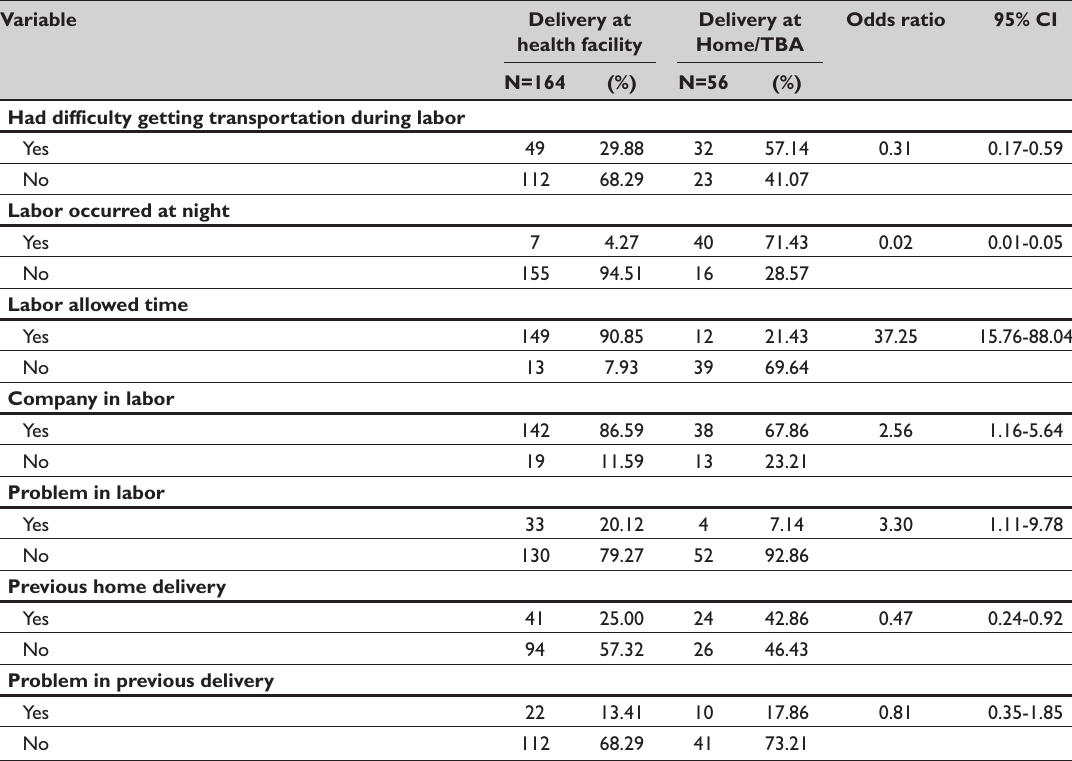
Table 3: Labor‑associated factors on choice of health facility delivery